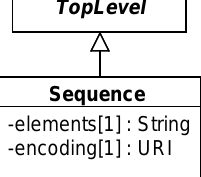
Figure 6: Diagram of the Sequence class and its associated properties.